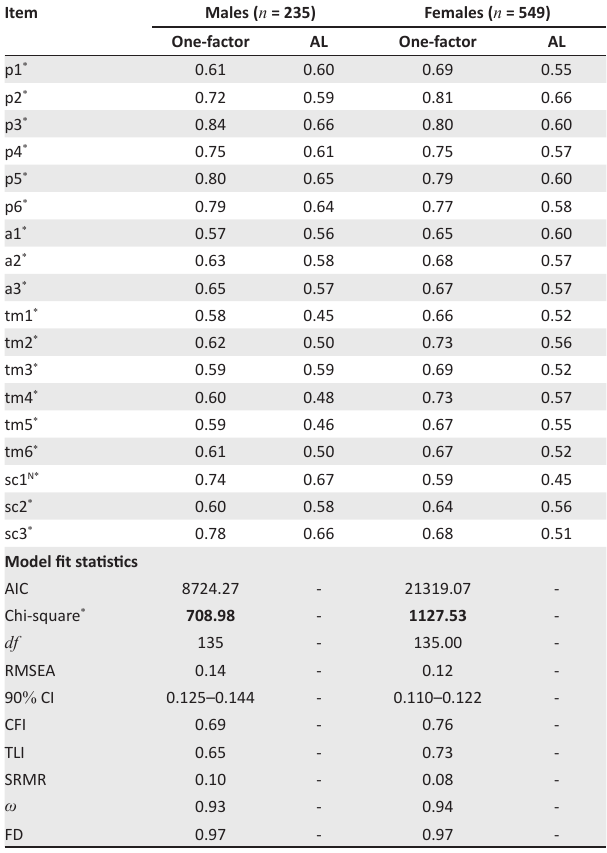
TABLE 3: Approximate invariance: One-factor (unidimensional) model for genders.